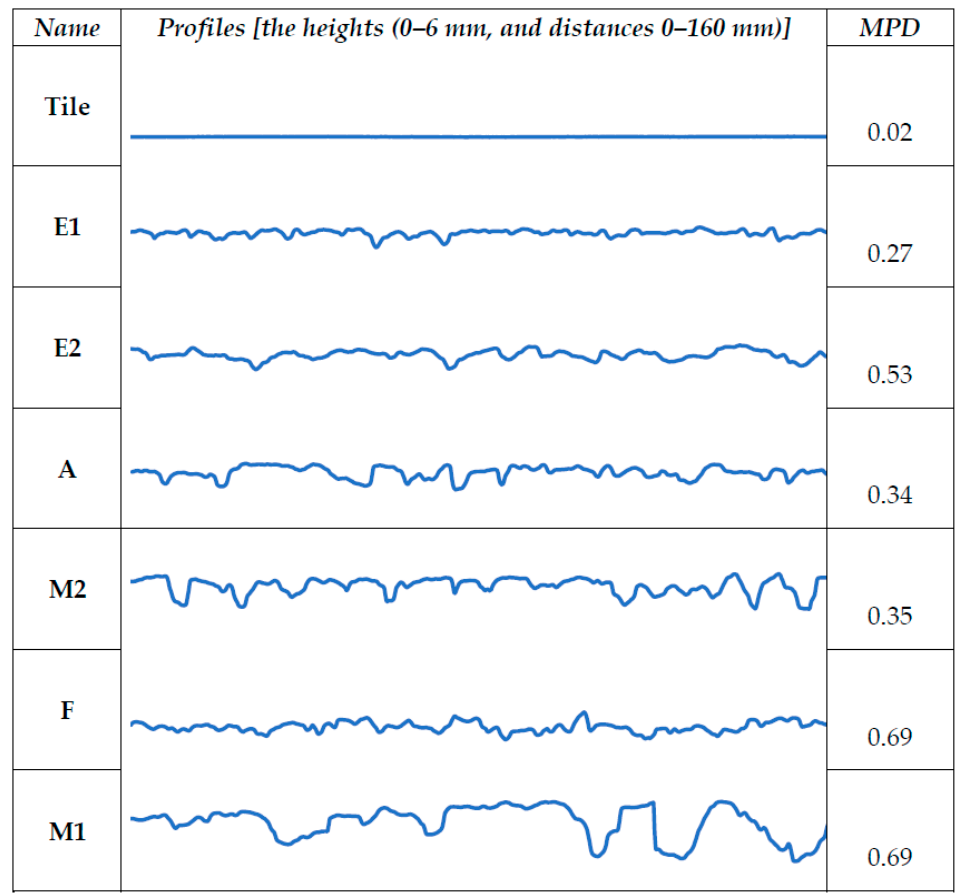
Figure 4. Profiles captured from these surfaces and their estimated MPD.